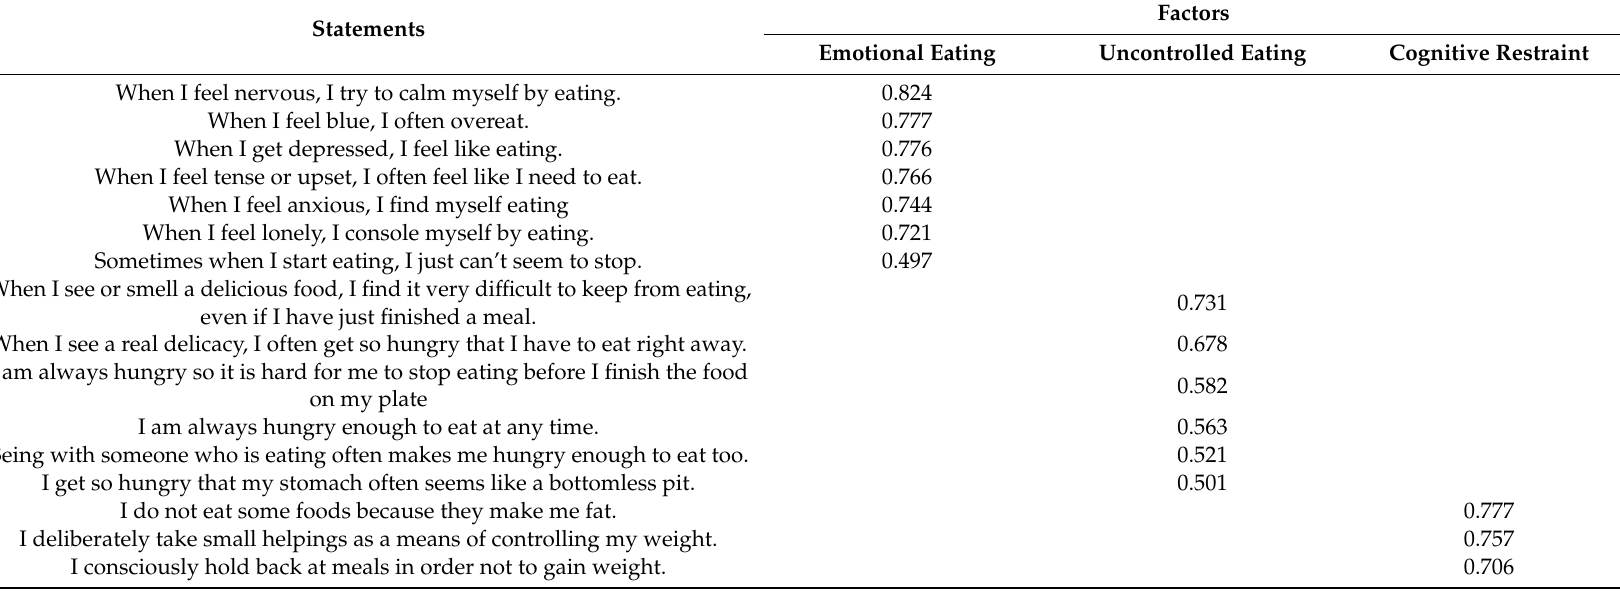
Table 8. The results of the exploratory factor analysis of the Three-Factor Eating